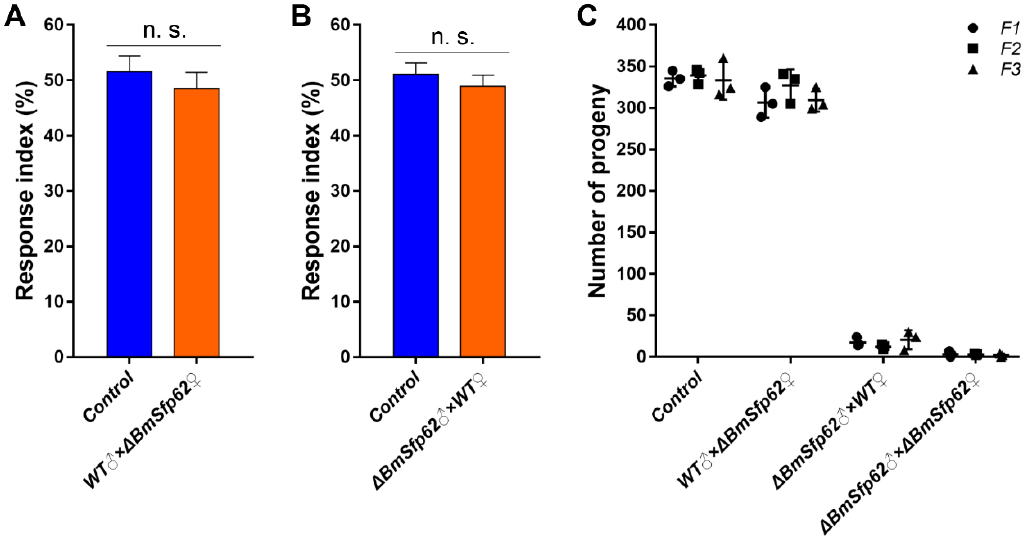
Figure 6. The BmSfp62 mutation does not impair competitiveness and is inherited. ( A ) Response indices of WT and ∆ BmSfp62 females. ( B ) Response indices of WT and ∆ BmSfp62 males. ( C ) Number of progenies with indicated mutations in F1 (circles), F2 (squares), and F3 (triangles) generations. The data shown are means ± S.E.M. ( n = 30/group). N.S. indicates no significance by a two-tailed t